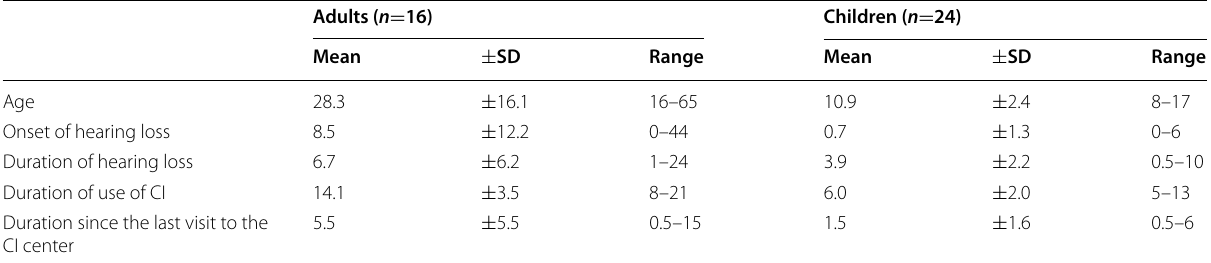
Table 1 Summary of the age of onset, duration of HL, duration of CI use, and duration since the last visit to the CI center